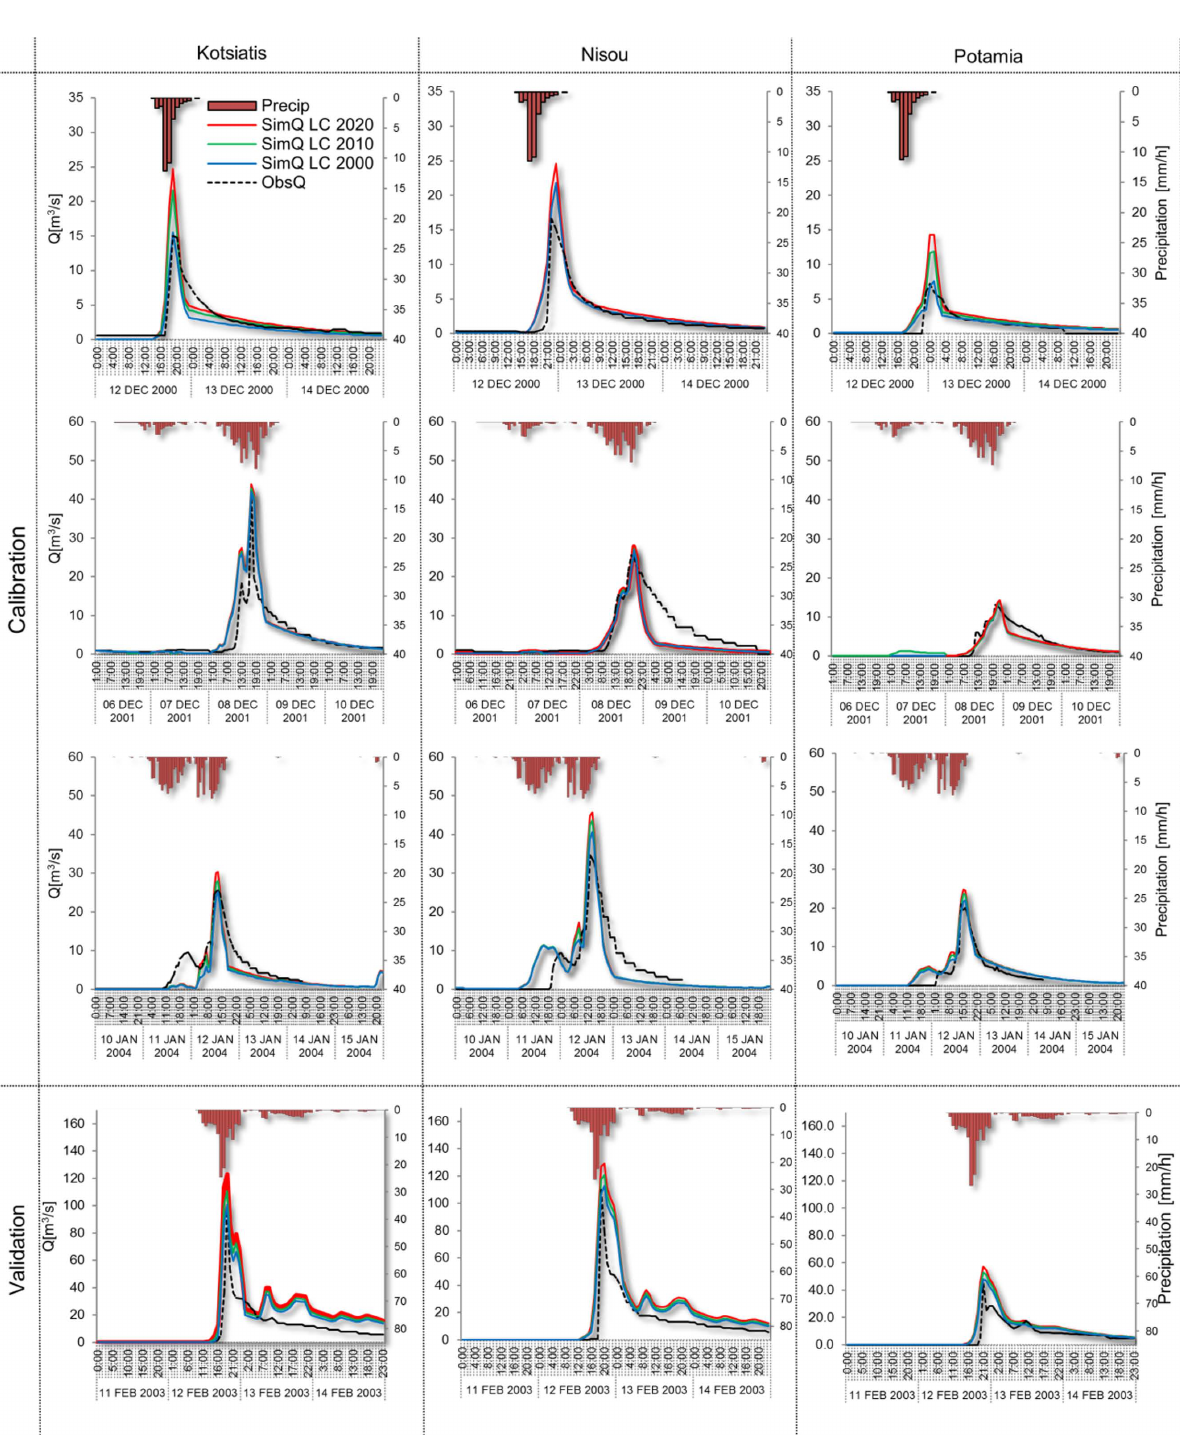
Fig. 7. Calibration and validation hydrographs for the observed and simulated flows. The land use 2010 (green lines) and 2020 (red lines) hydrological simulations are also